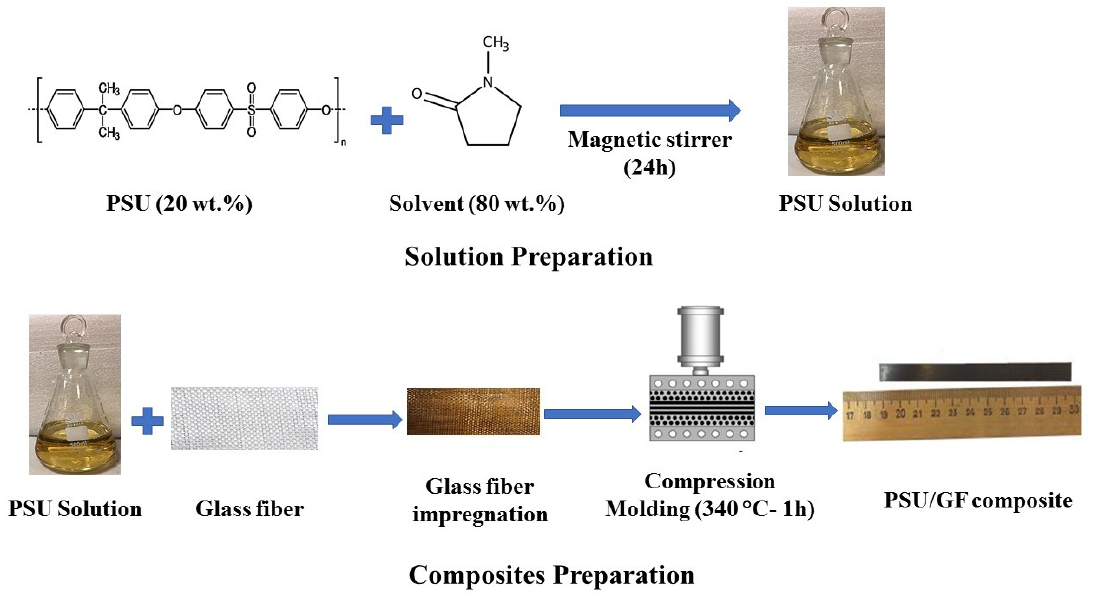
Figure 1. Scheme of the preparation of the polysulfone (PSU) solution and composites.